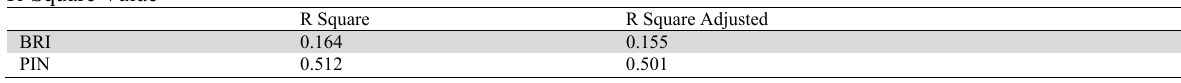
Hypothesis Testing Correlation Original Sample (O)